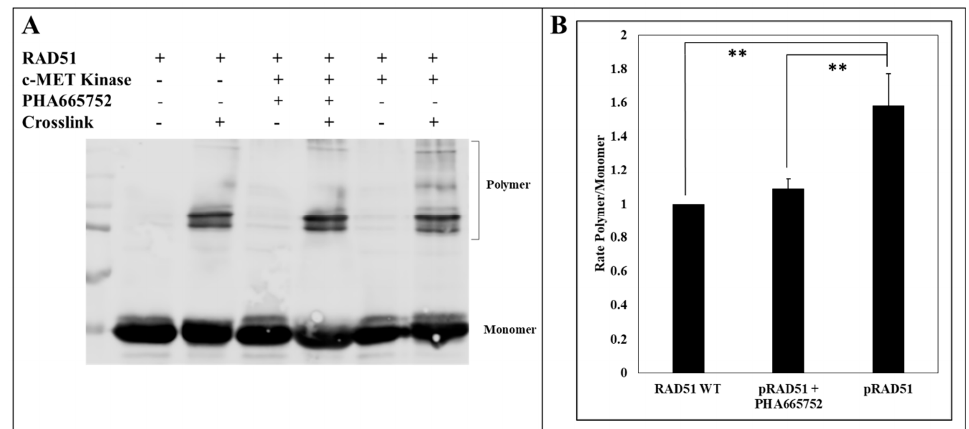
Figure 6. c-MET-mediated RAD51 phosphorylation promotes the formation of high-molecular-weight RAD51 oligomers. ( A ) The RAD51 WT protein (10 µM) was purified and incubated with ATP (2 mM) and with or without kinase-active c-MET (0.1 µM) and PHA665752 inhibitor (1 µM). Then, the proteins were crosslinked with BS3, separated by SDS-PAGE 10% gel and analyzed by western blot using anti-RAD51 antibodies. The signals were quantified by Odyssey scanner. ( B ) The graph represents the average of the ratios of the polymer forms of RAD51 phosphorylated or not by c-MET. The ratios were obtained after quantification of the blots from three independent experiments ( n = 3; error bars: s.d.; ** p < 0.01).